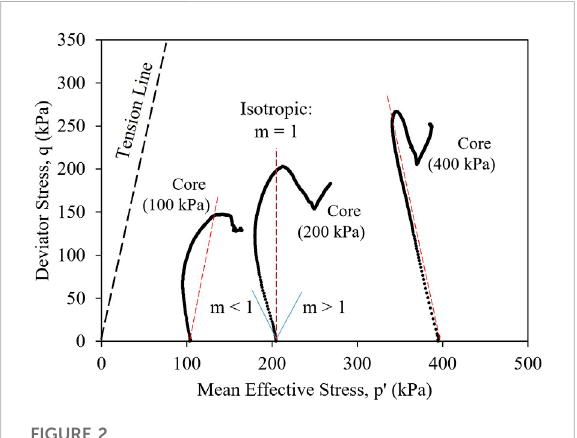
FIGURE 2 Stress paths in p ’ -q space from CIU triaxial tests on CB clay core samples.